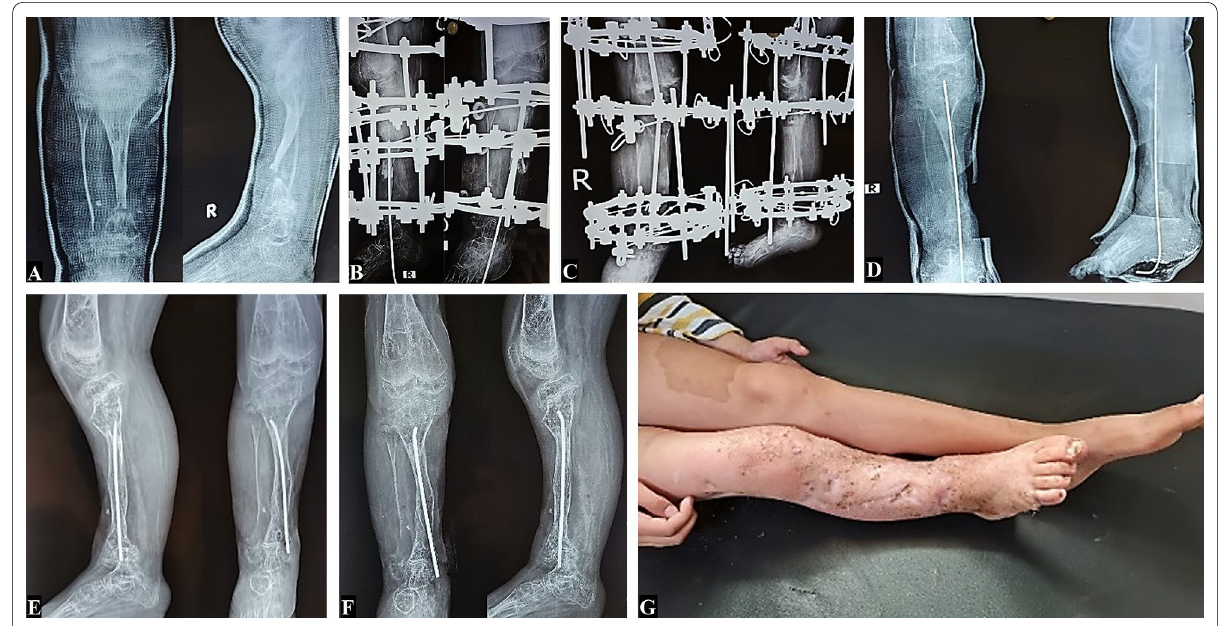
Fig. 2 A Preoperative AP and lateral X‑rays of a 7‑year‑old male who had undergone multiple previous surgeries for CPT since he was 1.5 years old, and had ended up with persistent CPT, posterior subluxation of the knee, genu recurvatum, and a very narrow, pencil‑shaped tibia. B AP and lateral postoperative X‑rays showing a trial correction of knee subluxation using a cross‑knee Ilizarov frame, excision of the CPT, and compensation by proximal corticotomy. Note the relative widening of the end of the proximal tibia compared to the preoperative size. C Four months’ follow‑up AP and lateral X‑rays showing 6 cm distraction with a good regenerate. D AP and lateral X‑rays taken immediately following fixator removal after full union with added transcalcaneal intramedullary K‑wire for protection of the union. E 1.5 years’ follow‑up AP and lateral X‑rays showing complete union and consolidation of both the docking site and the regenerate, with widened tibia at the docking site and replacement of the K‑wire by an IM titanium rod. F Two years’ follow‑up AP and lateral X‑rays after changing the IM rod. G Clinical photograph taken at 2 years’ follow‑up, showing 10 cm shortening of the affected